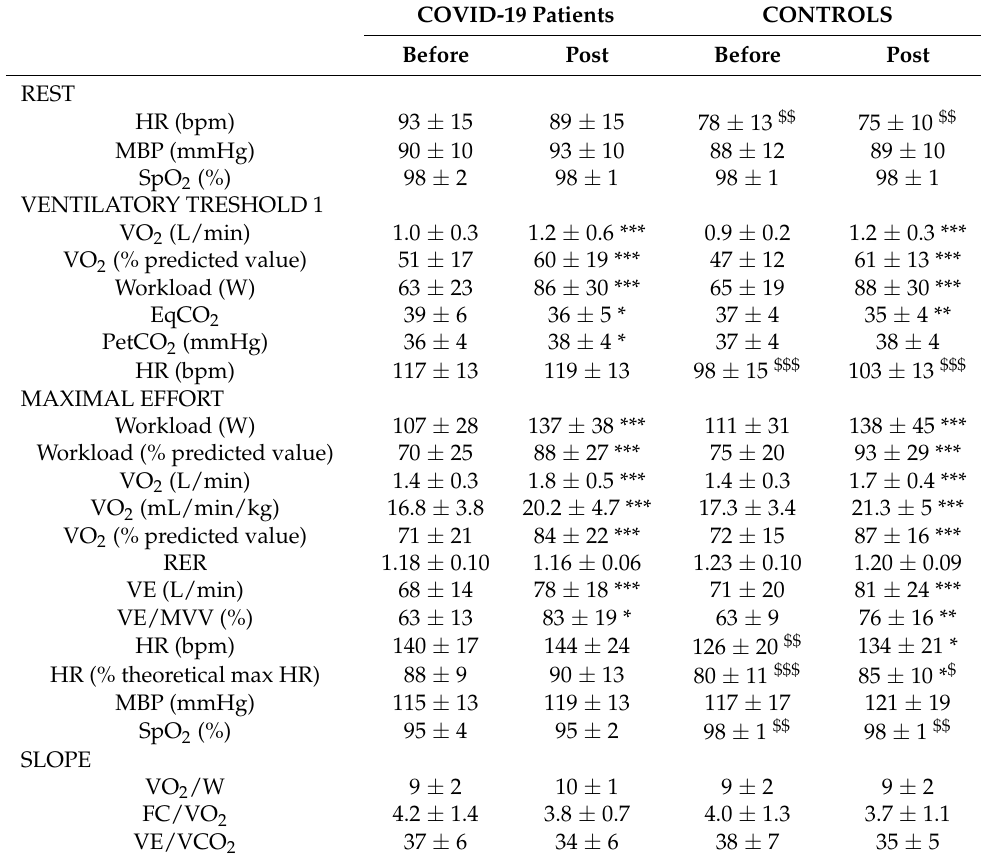
Table 3. Cardiopulmonary exercise testing before and after rehabilitation in 25 post-COVID-19 patients compared with 25 cardiac